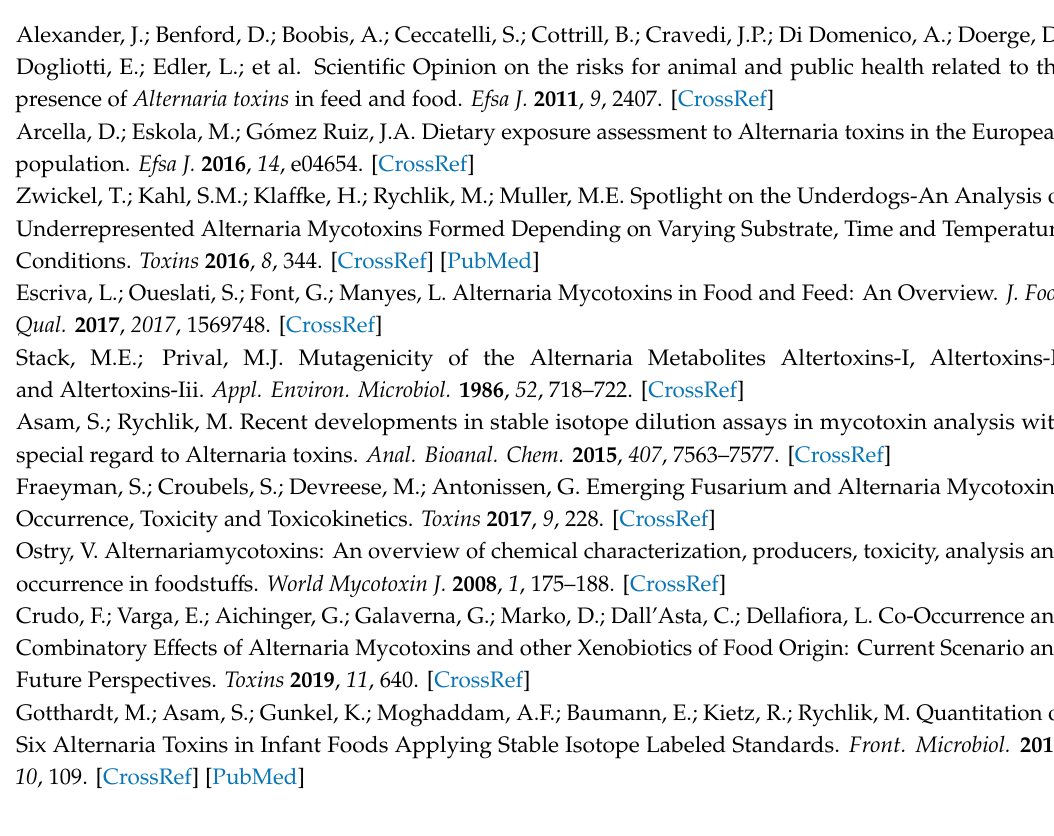
Figure S1: BCA assay after EROD measurements of 24 h of